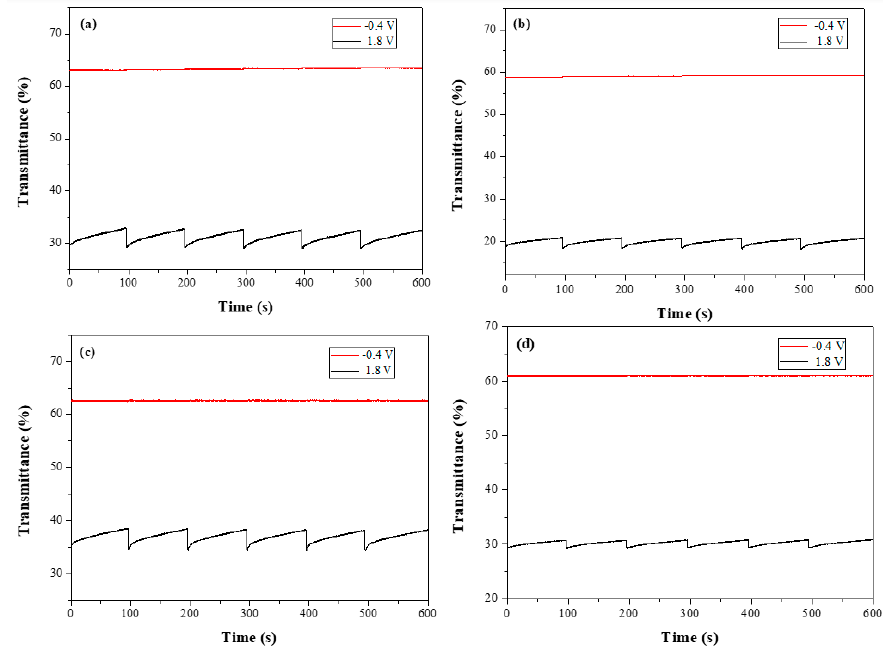
Figure 10. Open circuit stability of the ( a ) PbCmB/PEDOT, ( b ) P(bCmB- co -bTP)/PEDOT, ( c ) P(bCmB- co -dbBT)/PEDOT, and ( d ) P(bCmB- co -TF)/PEDOT ECDs.